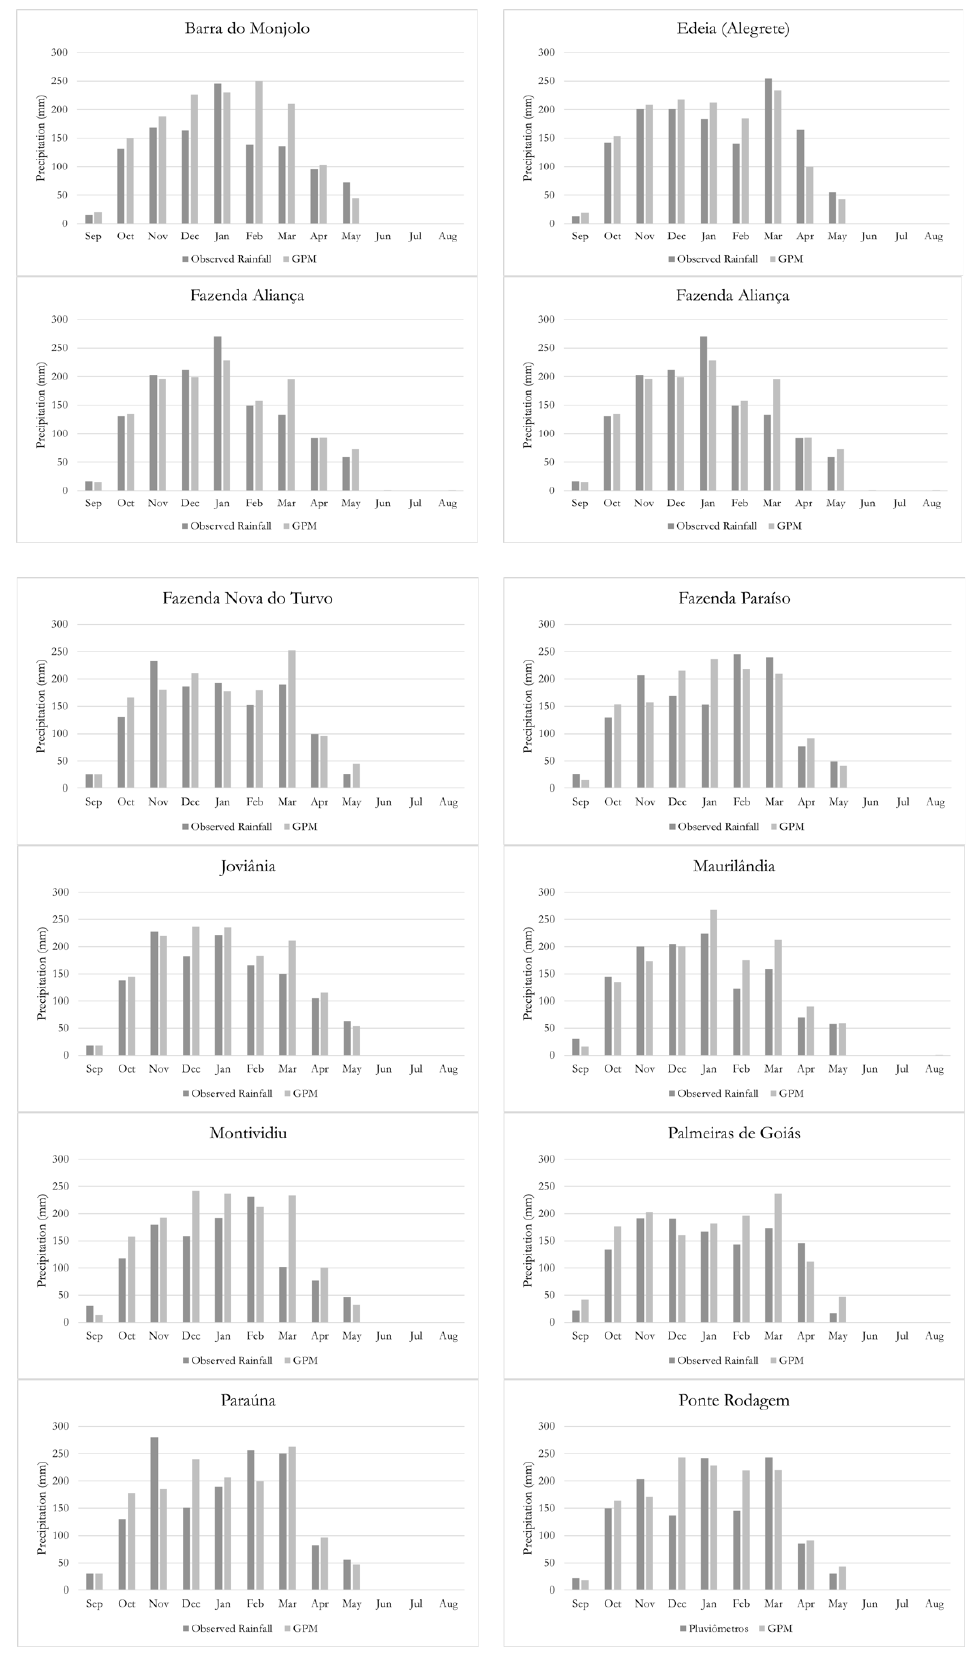
Figure 6. Monthly rainfall amounts as obtained from the GPM product and ground-based gauges for the Bois River catchment. Table 8. Goodness-of-fit metrics for monthly precipitation data from 12 gauging stations located in the Bois River catchment.